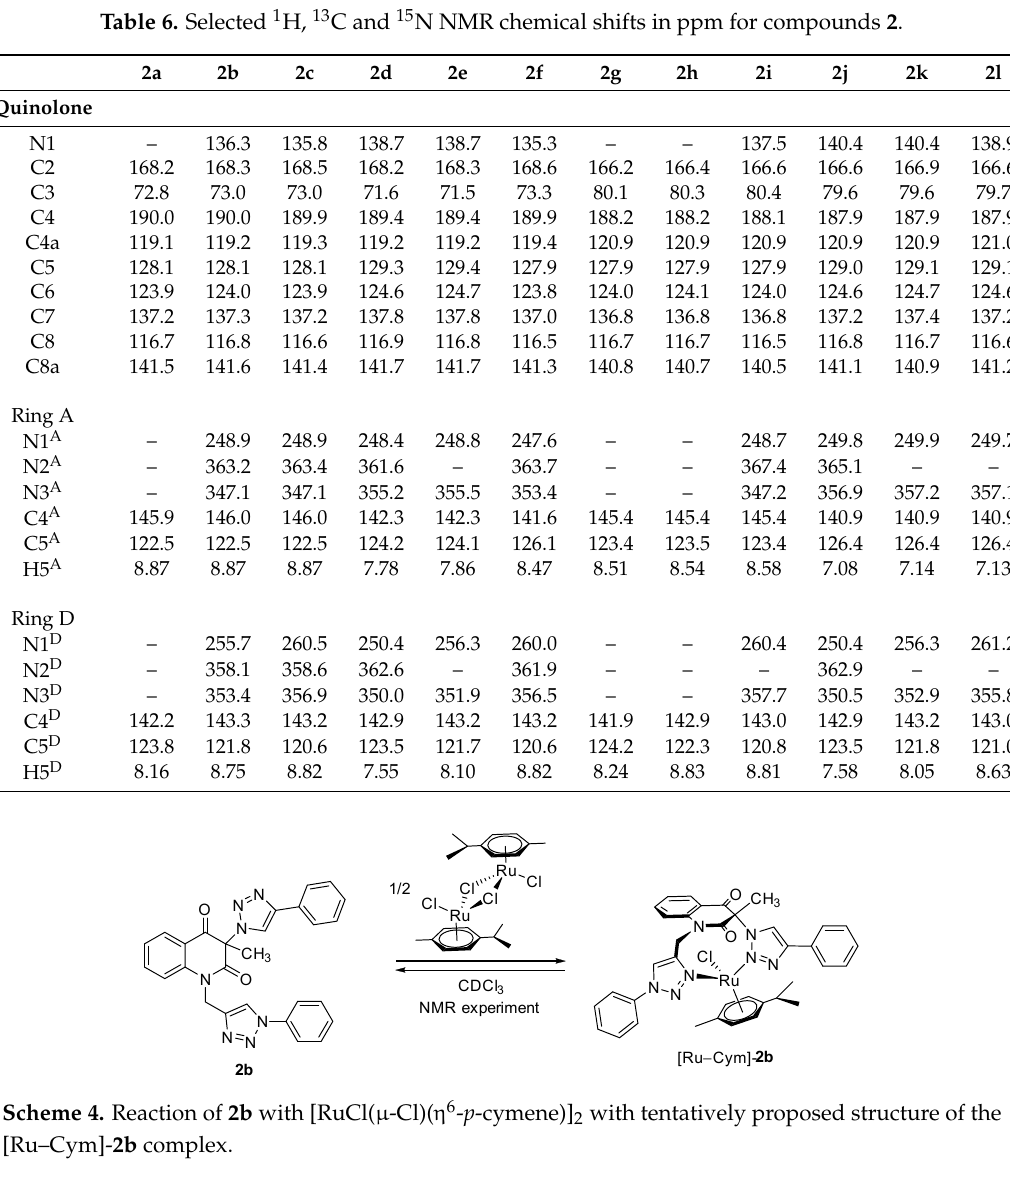
Scheme 4. Reaction of 2b with [RuCl( µ -Cl)( η 6 - p -cymene)] 2 with tentatively proposed structure of the